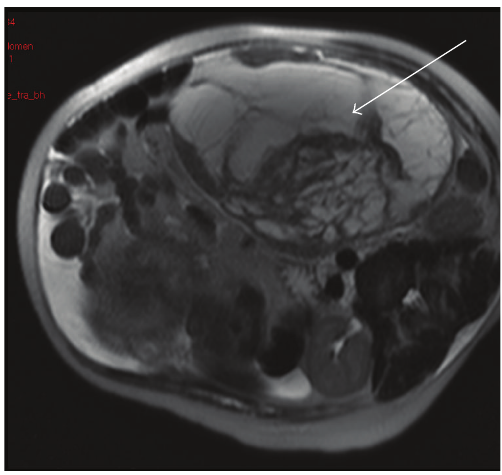
Figure 1: MRI abdomen, arrow indicating complex ovarian mass. (range 0.6–80), 17 OH-progesterone 295.0 nmol/L (range < 13.0), CEA 1.8 ng/mL (range < 6.0), and CA125 389.7 U/mL (range < 35.0)